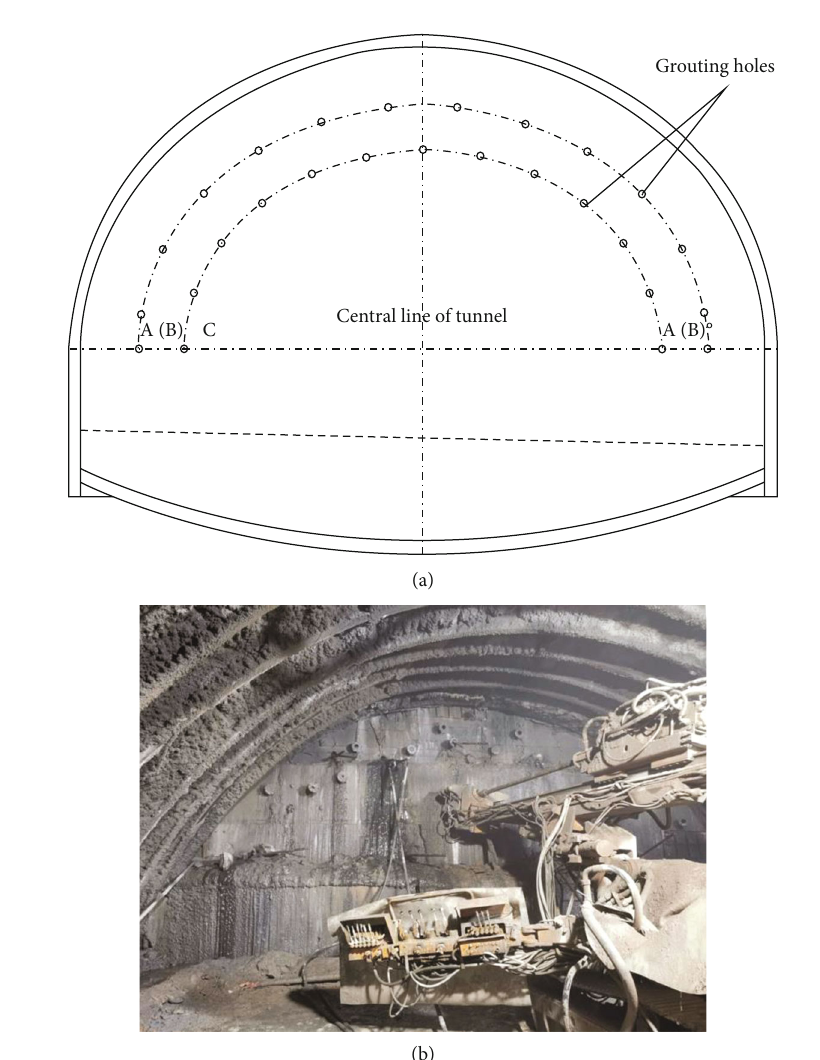
Figure 10: Curtain grouting construction: (a) layout of grouting hole; (b) construction site of curtain